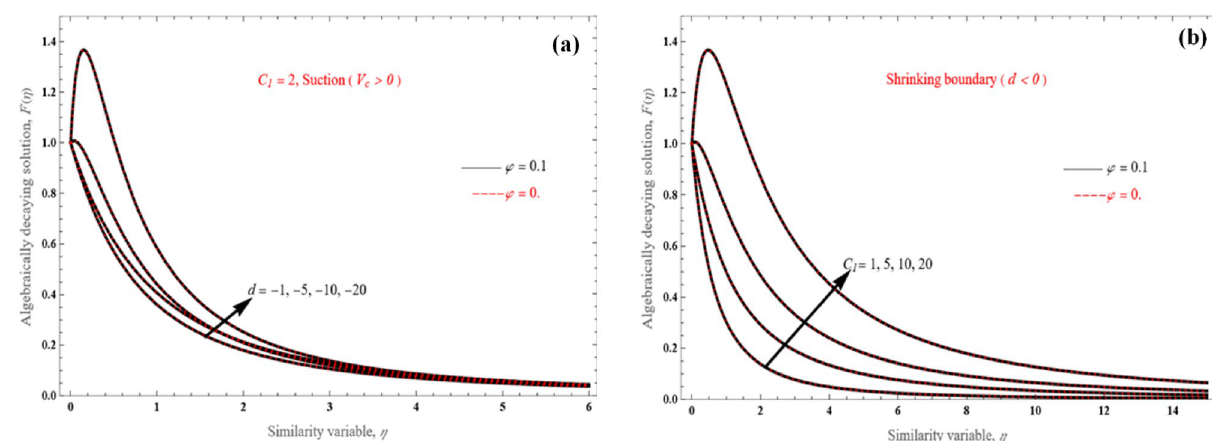
Figure 6. F (η) vs. the similarity variable for ( a ) various values of d and ( b ) various positive values of C 1